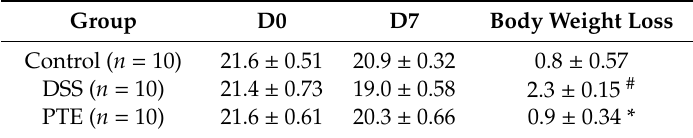
Table 4. E ff ects of PT extracts on the body weight loss by